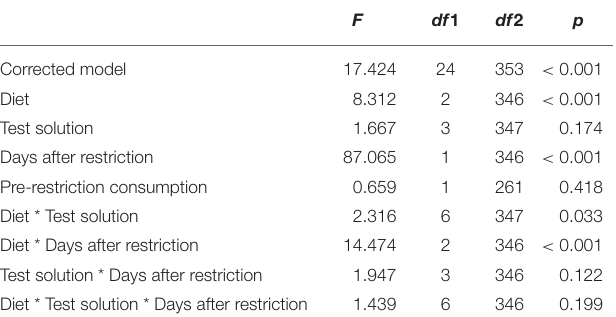
TABLE 1 | Test statistics for the generalized linear mixed model with consumption of the test solution as the target variable. F df 1